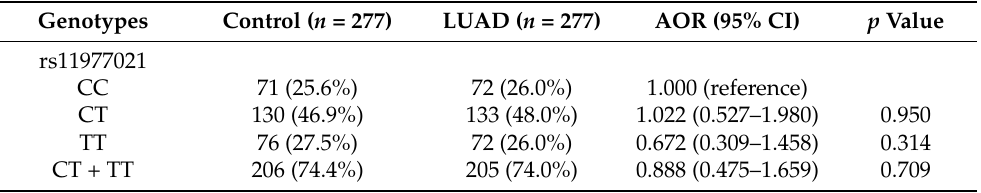
Table 2. Adjusted odds ratios (ORs) with their 95% confidence intervals (CIs) for lung adenocarcinoma associated with Visfatin genotype